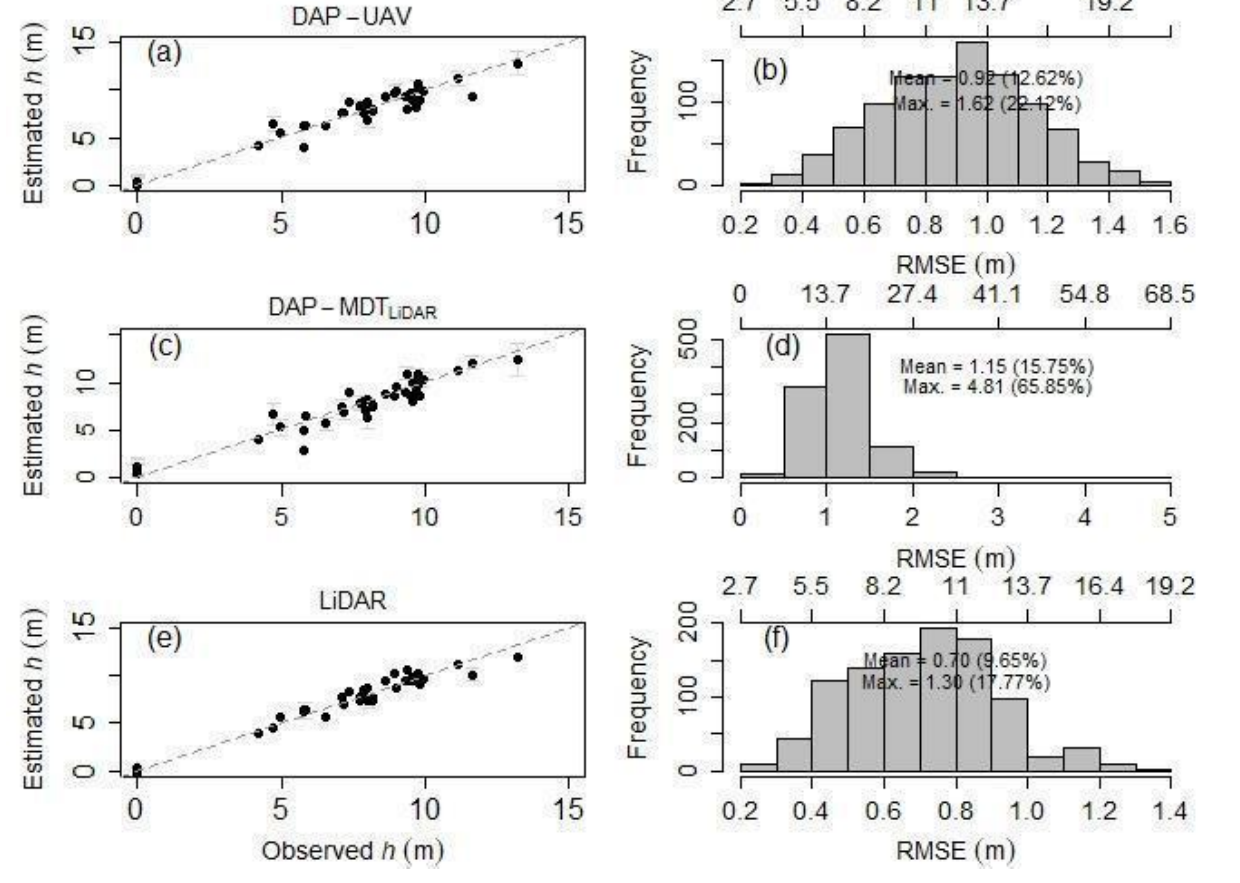
Figure 10. Scatter plots between the estimated and observed mean h values for ( a ), ( c ), and ( e ) and the frequency histograms of RMSE in the validation of models ( b ), ( d ), and ( f ) for DAP, DAP-DTM LiDAR , and LiDAR.